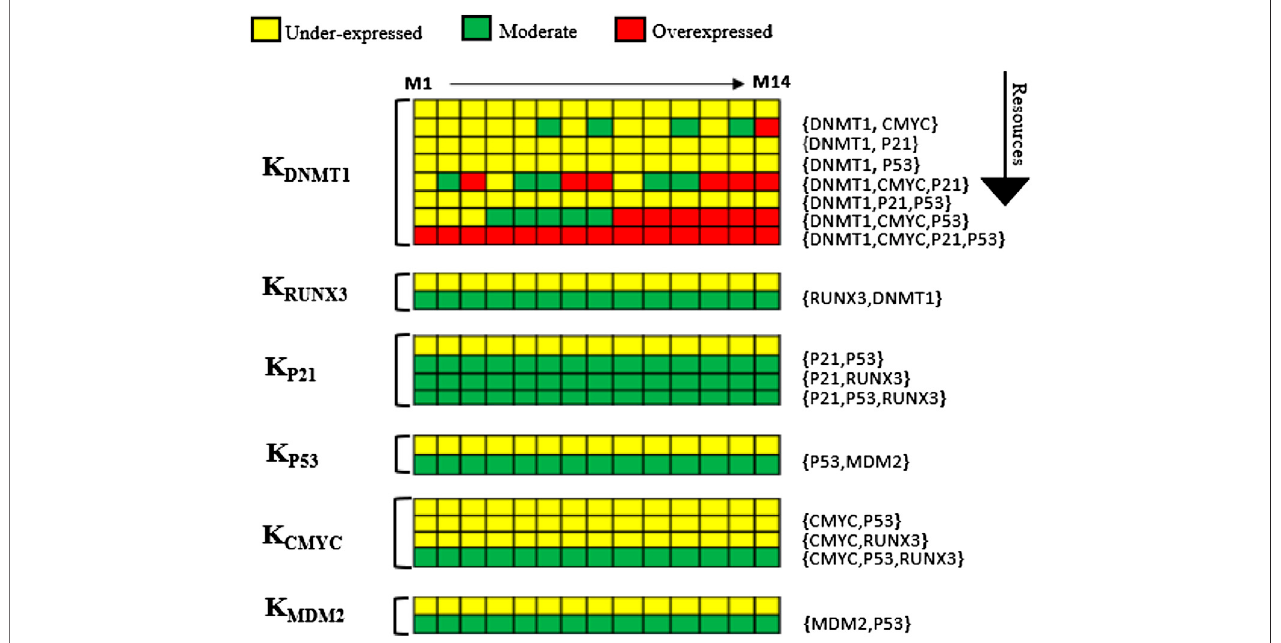
FIGURE 4 | Heat map of logical parameters computed on SMBioNet shows 14 distinct sets of parameters. A preferred set of parameters were estimated through modelcheckingrenderedasheatmapalongwiththeirresources(M1 – M14).Eachcolumnrepresentsadistinctsetoflogicalparameterswhereamoderateexpressionof an entity is expressed using green color, an overexpression is expressed using red color, and an underexpression is illustrated using yellow color in the heat